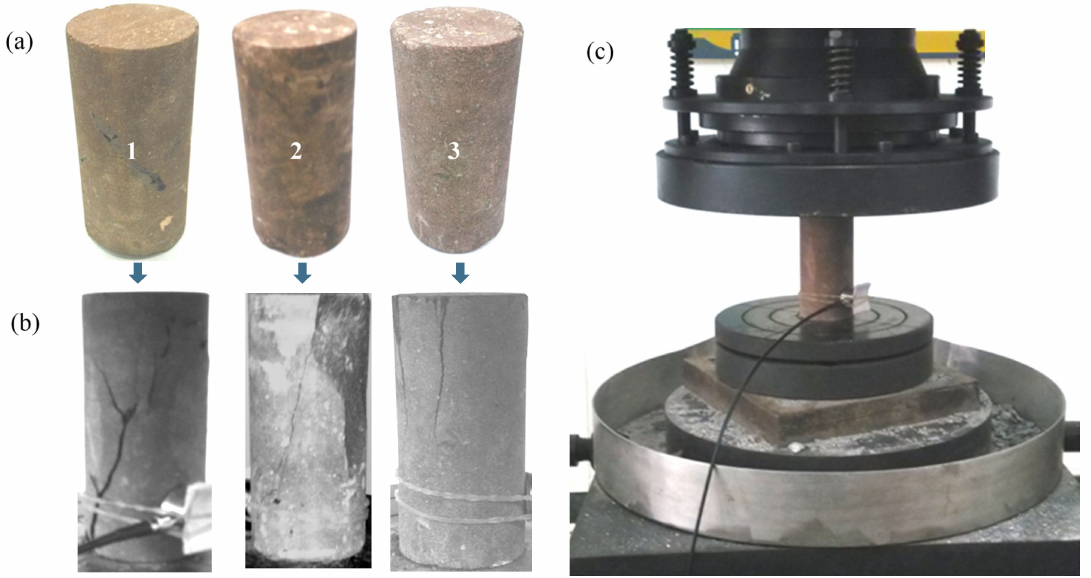
Figure 5. Rock samples and their loading conditions: ( a ) silty mudstone samples, ( b ) damaged rock samples after uniaxial compression test, ( c ) instrument and loading